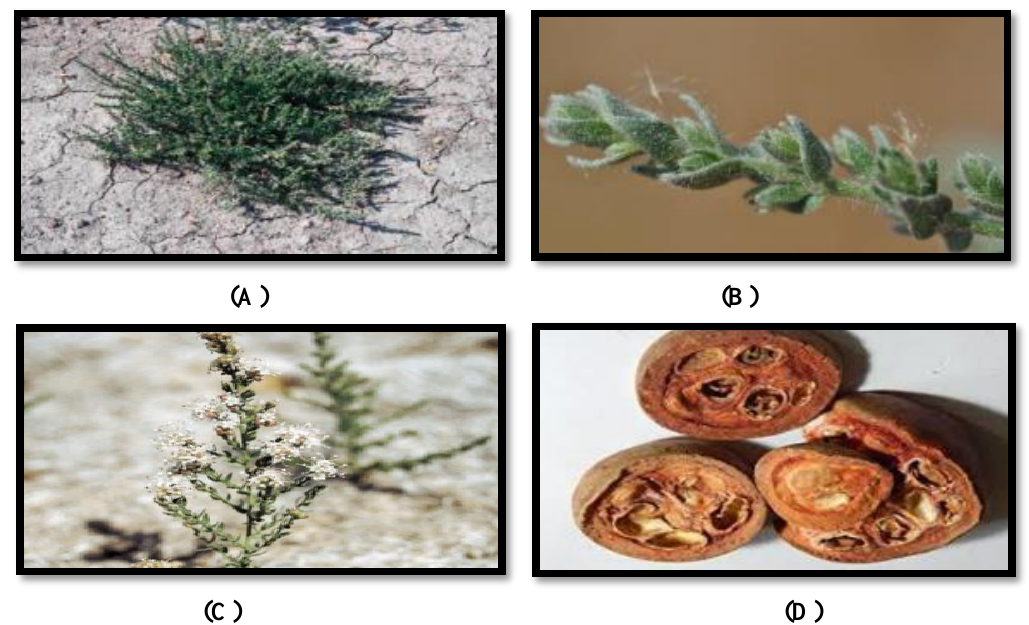
Figure 1. Cressa cretica (A): Whole plant, (B): Stem and leaves, C: upper flowering part, (D): Seeds (25, 28).